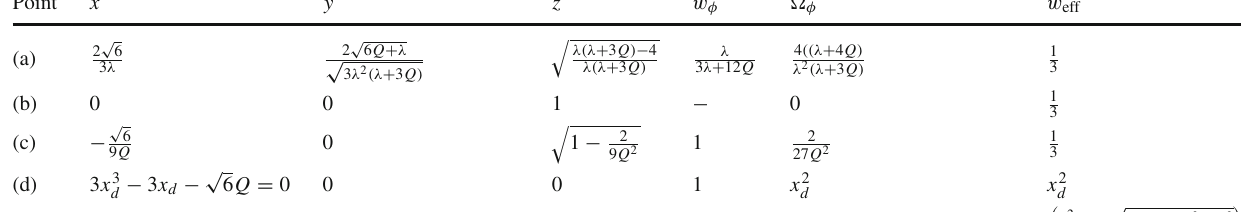
Point Stability